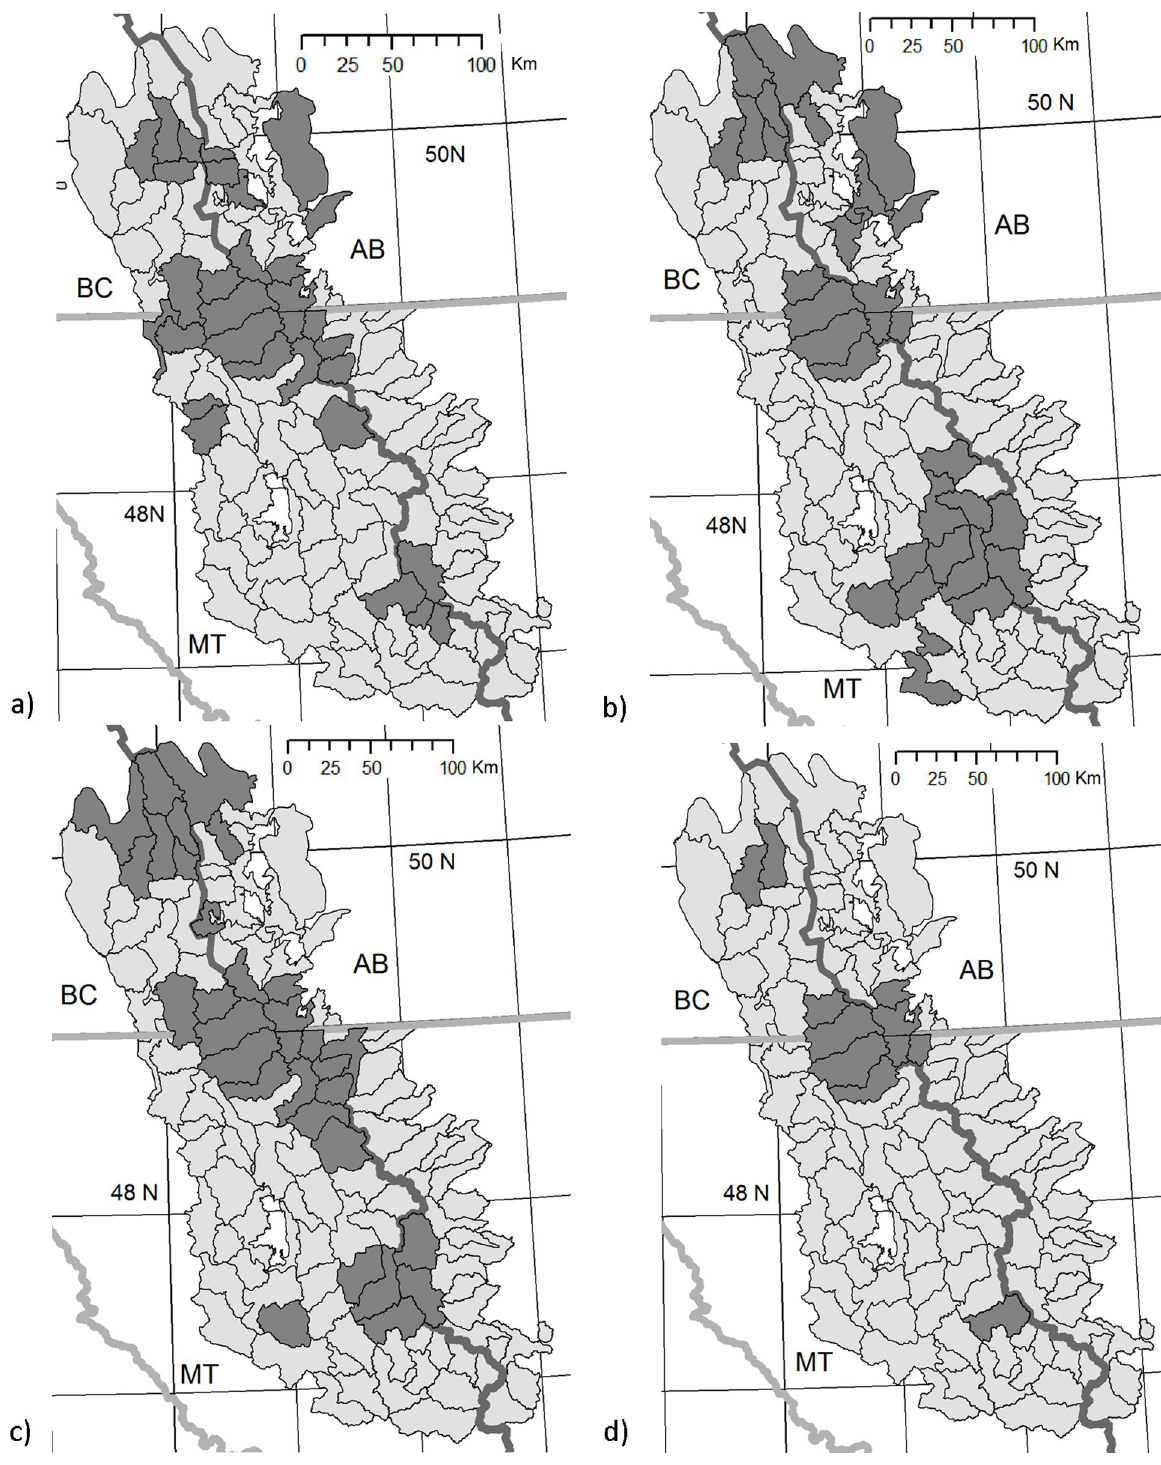
Fig 3. Crown of the Continent high retention watersheds as measured by warm, dry and spring retention of SWE. Dark shaded watersheds indicate > 75 th percentile ranking for: (a) warm retention, (b) dry retention and (c) spring retention. Watersheds ranking high for all 3 measures of retention are shown in (d). Contains information licensed under the Open Government